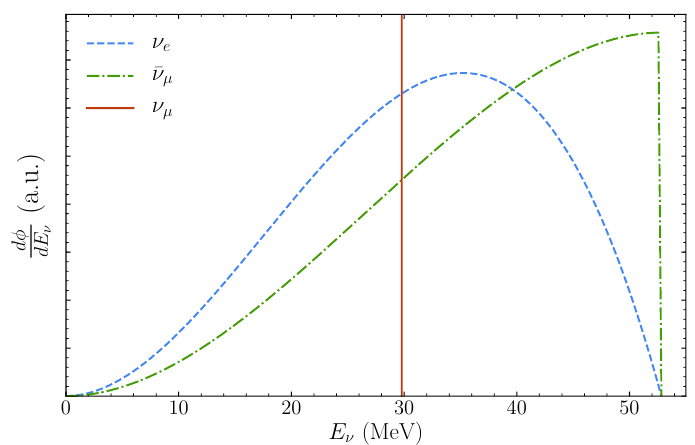
Figure 2 . Neutrino (cid:13)ux spectra expected from pion DAR, in arbitrary units (a.u.), as a function of the neutrino energy in MeV. The three components of the (cid:13)ux are shown separately as indicated by the legend. The distributions have been normalized to